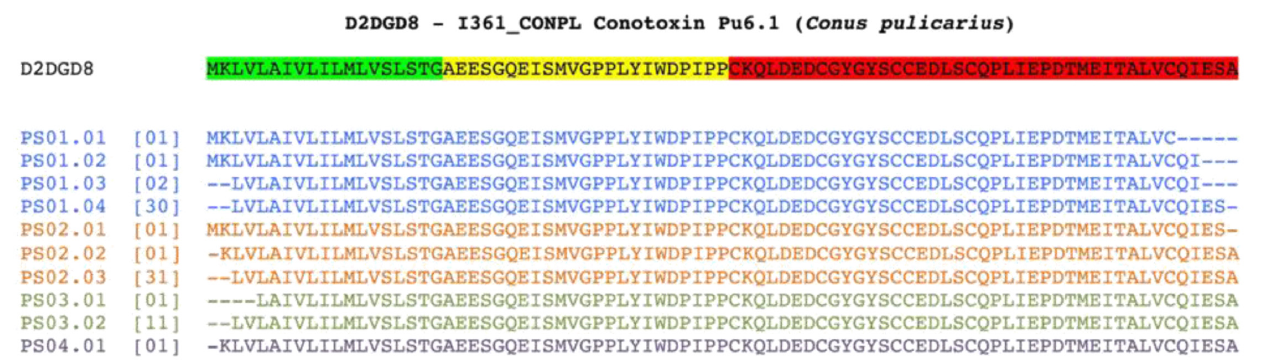
Figure 4. Alignment of toxin-like peptides to Conotoxin Pu6.1 precursor. Conotoxin Pu6.1 precursor from Conus pulicarius (UniprotKB: D2DGD8) is aligned with the toxin-like peptides identified in four out of five plasma samples. Being the protein secreted and cleaved, leader- region pro-peptide and mature cysteine rich domains are highlighted in green, yellow and red, respectively. The shown peptides correspond to the longest observed peptides, as we did not make any specific selection for secreted proteins, precursors are expected to be present in our samples. Each identified toxin-like peptide is named according to the sample of origin and its uniqueness. For each of them, the number reported in square brackets indicates the number of identical toxin-like peptides identified in the same